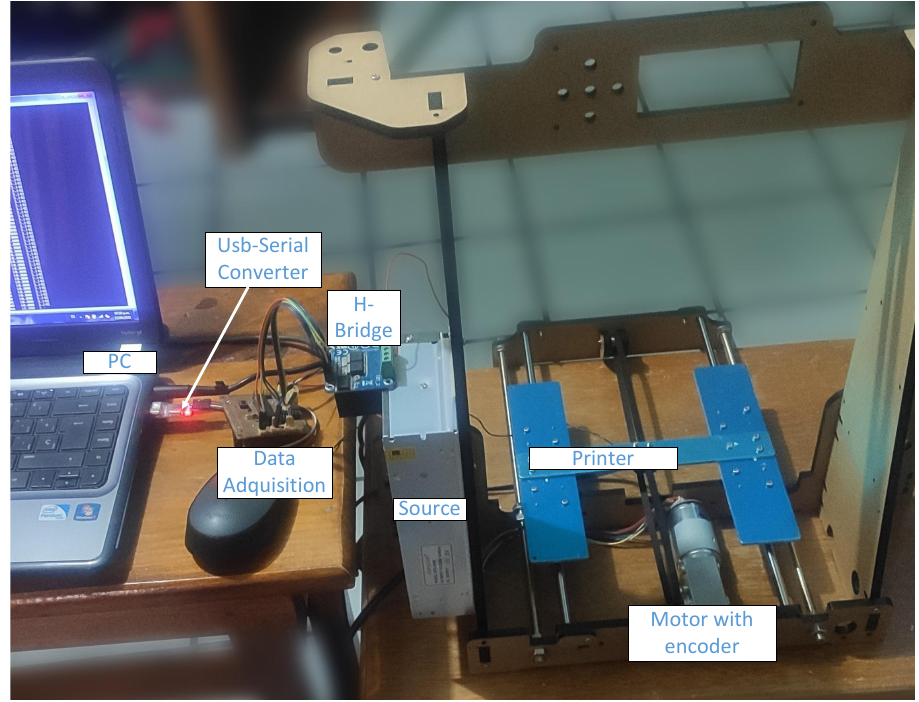
Figure 2. Experimentation platform designed for the